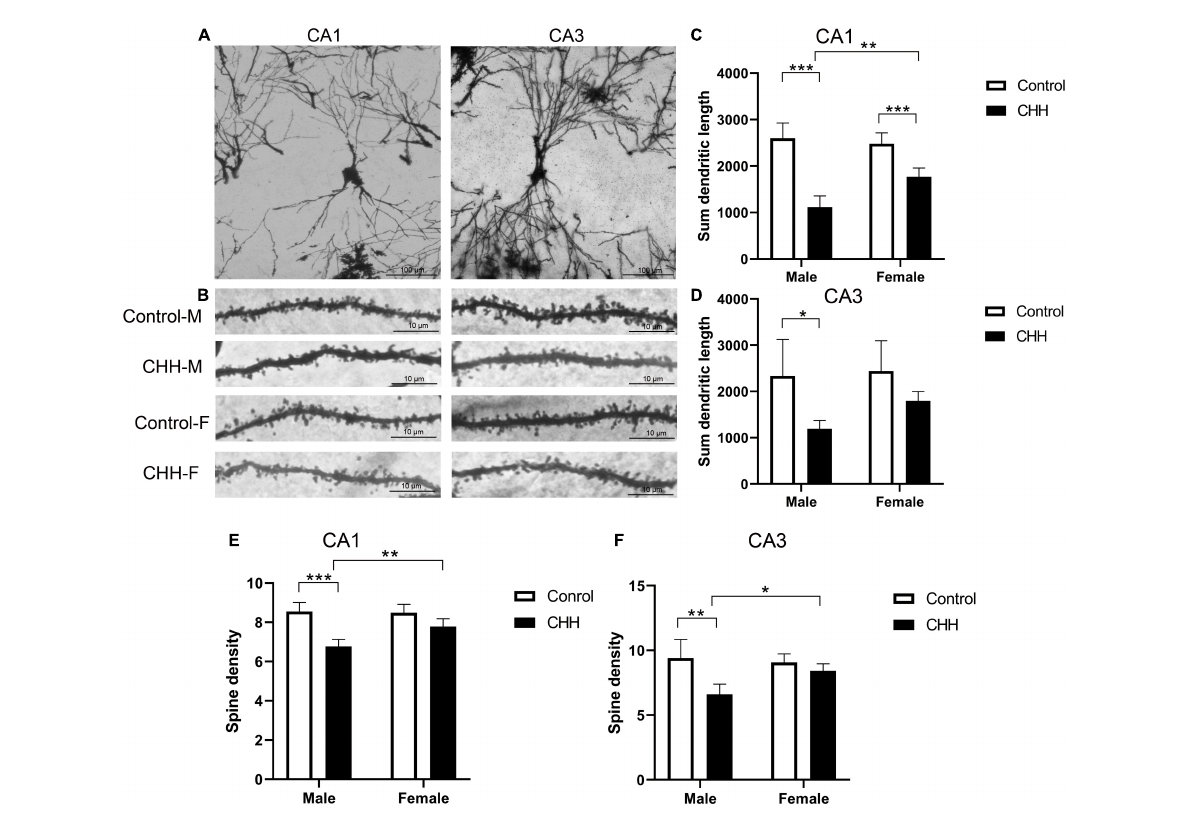
FIGURE8 Effects of CHH on dendritic spines of hippocampal neurons in female and male rats. (A) Golgi-Cox staining showed dendritic branches in CA1 and CA3 regions, scale bar: 100 µ m; (B) Golgi-Cox staining showed dendritic spine images in CA1 and CA3 regions, scale bar: 10 µ m; (C,D) compared with the control group, the total dendritic length in CA1 (C) and CA3 (D) regions of female rats in CHH group decreased; (E,F) compared with the control group, neurons from female CHH rats also showed a decrease in the number of dendritic spines in the CA1 (E) and CA3 (F) regions. M, male; F, female. Values are means ± SD for five animals/group. Data for male and female rats, with or without CHH exposure, were analyzed using two-way ANOVA. Post hoc analysis indicated: * p < 0.05, ** p < 0.01, *** p <